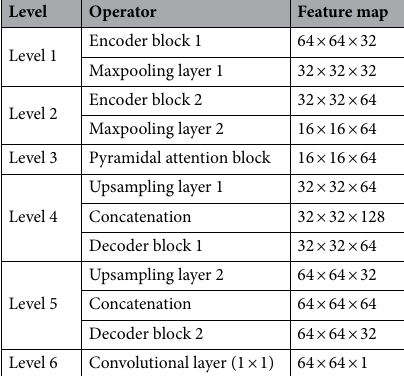
Table 1. Feature Map Details of Lung_PAYNet.